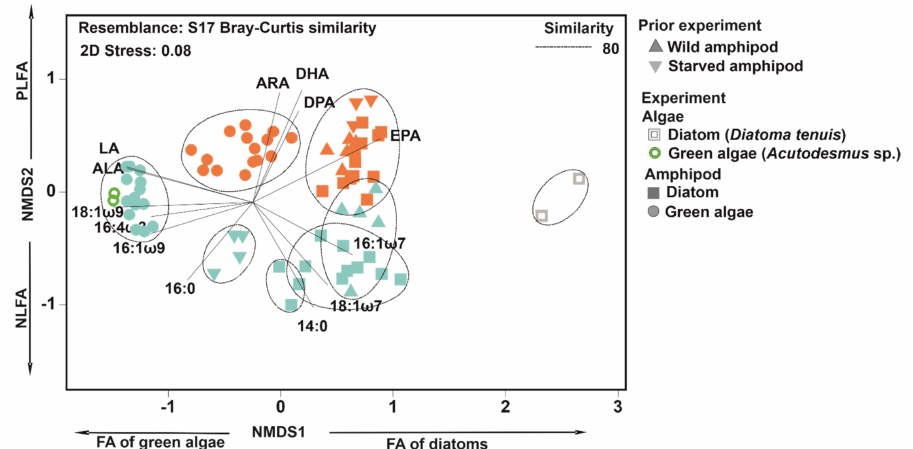
Figure 3. Nonmetric multidimensional scaling (NMDS) for fatty acid profiles of total lipids neutral lipids (NL, cyan colour of symbols) and phospholipids (PL, orange colour of symbols) of amphipods ( Pallaseopsis quadrispinosa ) in green algae and diatom treatments including wild (day − 12) and starved individuals (day 0). Shape of symbols refers to the treatments and colour of symbols to lipid fraction. Vectors show Pearson’s correlations (r > 0.8) of individual fatty acids with the axis of NMDS1 and 2. Dashed-lined clusters are based on >80% similarity in Cluster